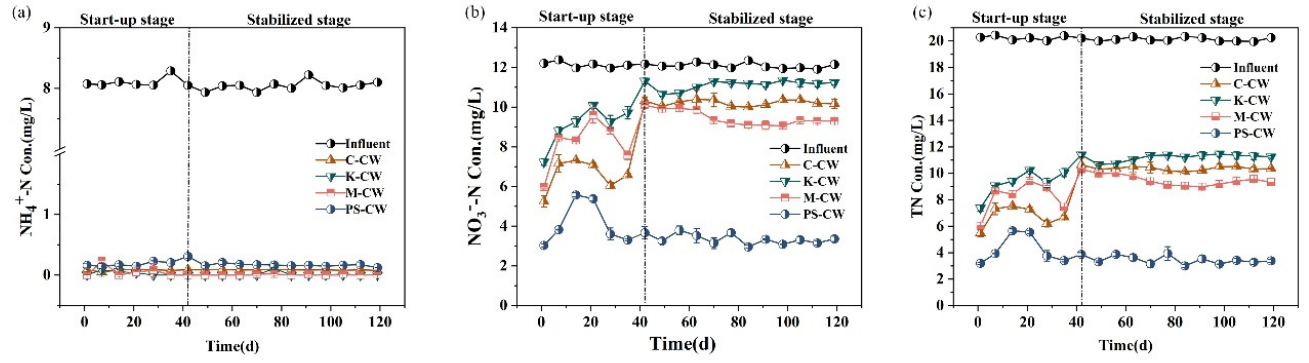
Figure 1. The influent and effluent concentrations of NH 4+ -N ( a ), NO 3 − -N ( b ) and TN ( c ) in CWs throughout the experimental period.